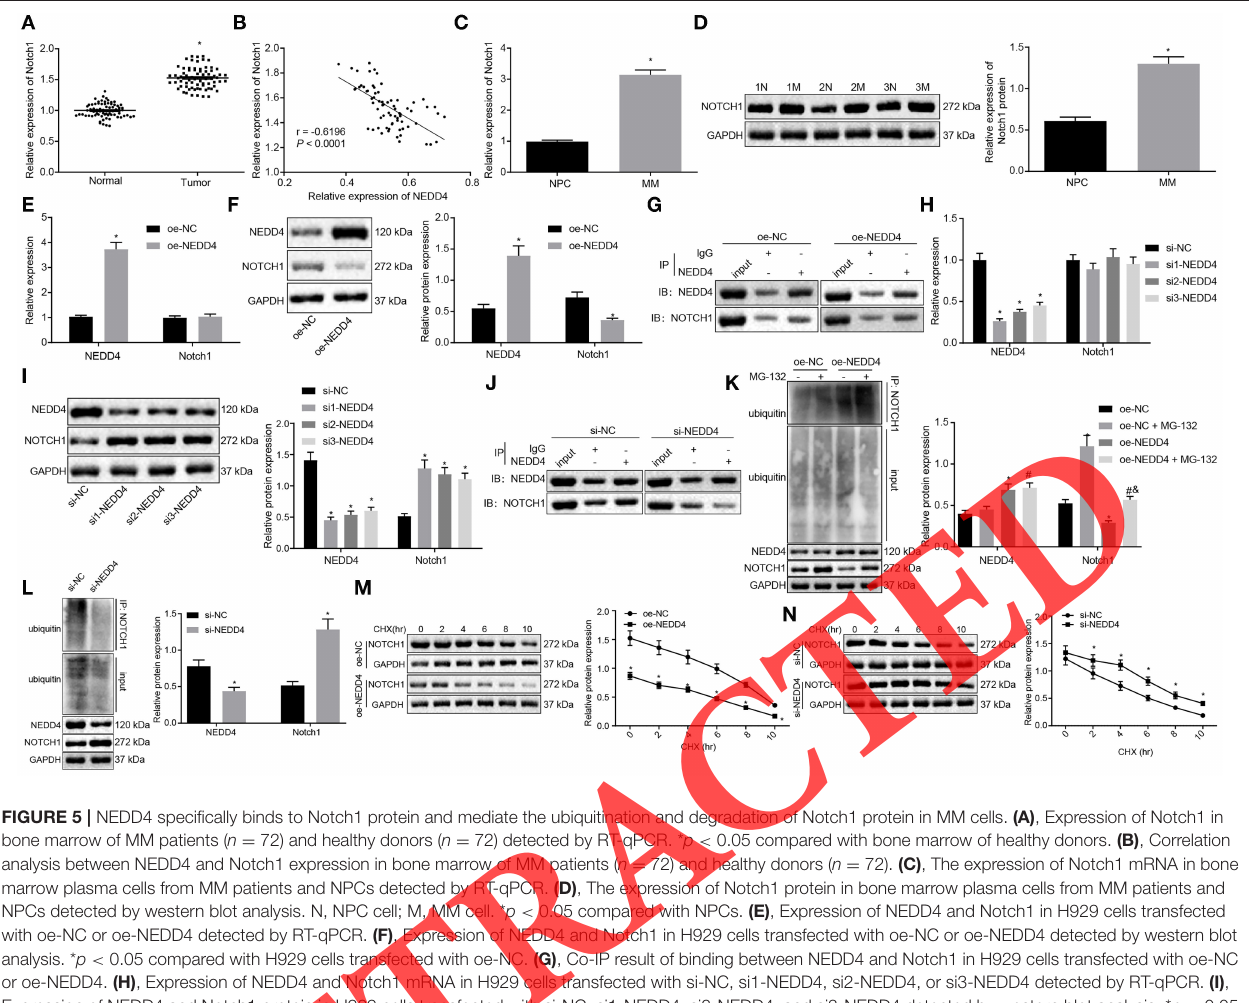
FIGURE 5 | NEDD4 specifically binds to Notch1 protein and mediate the ubiquitination and degradation of Notch1 protein in MM cells. (A) , Expression of Notch1 in bone marrow of MM patients ( n = 72) and healthy donors ( n = 72) detected by RT-qPCR. * p < 0.05 compared with bone marrow of healthy donors. (B) , Correlation analysis between NEDD4 and Notch1 expression in bone marrow of MM patients ( n = 72) and healthy donors ( n = 72). (C) , The expression of Notch1 mRNA in bone marrow plasma cells from MM patients and NPCs detected by RT-qPCR. (D) , The expression of Notch1 protein in bone marrow plasma cells from MM patients and NPCs detected by western blot analysis. N, NPC cell; M, MM cell. * p < 0.05 compared with NPCs. (E) , Expression of NEDD4 and Notch1 in H929 cells transfected with oe-NC or oe-NEDD4 detected by RT-qPCR. (F) , Expression of NEDD4 and Notch1 in H929 cells transfected with oe-NC or oe-NEDD4 detected by western blot analysis. * p < 0.05 compared with H929 cells transfected with oe-NC. (G) , Co-IP result of binding between NEDD4 and Notch1 in H929 cells transfected with oe-NC or oe-NEDD4. (H) , Expression of NEDD4 and Notch1 mRNA in H929 cells transfected with si-NC, si1-NEDD4, si2-NEDD4, or si3-NEDD4 detected by RT-qPCR. (I) , Expression of NEDD4 and Notch1 protein in H929 cells transfected with si-NC, si1-NEDD4, si2-NEDD4, and si3-NEDD4 detected by western blot analysis. * p < 0.05 compared with H929 cells transfected with si-NC. (J) , Co-IP result of binding between NEDD4 and Notch1 in H929 cells transfected with si-NC or si-NEDD4. (K) , The ubiquitination level of Notch1 in H929 cells after treatment with oe-NEDD4 and MG-132. * p < 0.05 compared with H929 cells transfected with oe-NC, # p < 0.05 compared with H929 cells treated with oe-NC + MG-132, & p < 0.05 compared with H929 cells treated with oe-NEDD4. (L) , The ubiquitination level of Notch1 in H929 cells after silencing NEDD4. * p < 0.05 compared with H929 cells treated with si-NC. (M) , Half-life of Notch1 in H929 cells after overexpressing NEDD4. * p < 0.05 compared with H929 cells transfected with oe-NC. (N) , Half-life of Notch1 in H929 cells after silencing NEDD4. * p < 0.05 compared with H929 cells treated with si-NC. The result data were measurement data and expressed as mean ± standard deviation. Unpaired t -test was used for comparison between two groups, and one-way ANOVA was used for comparison among multiple groups. Pearson correlation was used to analyze the relationship between NEDD4 and Notch1, and data at different time points were compared using two-way analysis of variance. The cell experiment was repeated three